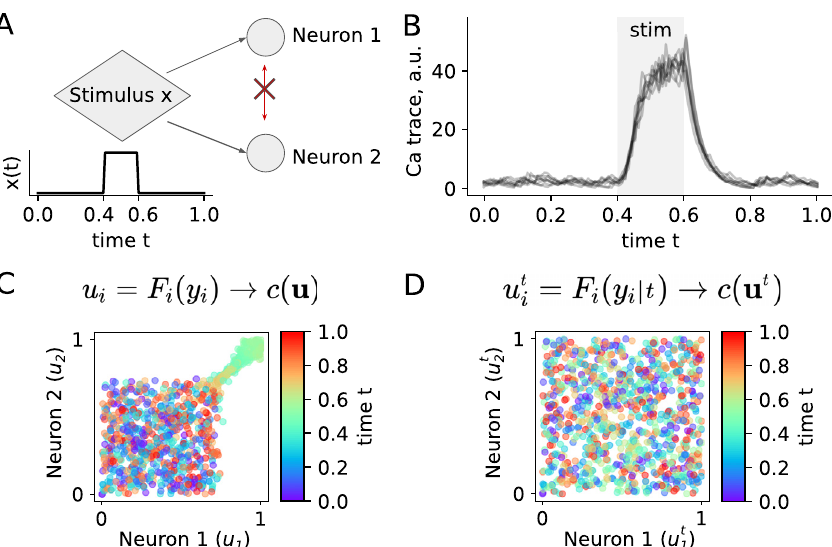
Fig 2. Copula-GP finds that uncoupled neurons are independent given the stimulus. A GLM model of two identical uncoupled neurons that receive the same time-dependent input x ( t ); B simulated calcium transients (fluorescence across time) showing dynamic responses to the stimulus x ( t ) for one of the neurons; C calcium transients of two neurons ( y 1 ( t ), y 2 ( t )) projected onto a unit cube by the probability integral transform based on unconditional marginals; colored points show transformed samples ( u 1 , u 2 ) corresponding to times t (color-coded). The clusters of similarly colored points (e.g. green) illustrate that the copula c ( u ) depends on time t ; the particular shape and the location of the clusters depends on the function x ( t ); only 10% of data-points are shown (selected randomly). D same as C, but based on conditional marginals F ( y | t ). The resulting empirical copula describes ‘noise correlations’ between i i two neurons. The colored data-points ( u t , u t ) are uniformly distributed on the unit square, which suggests that there is 1 2 no noise correlation between these neurons, the copula c ( u t ) is independent of time t , and the neurons are independent given the time-dependent